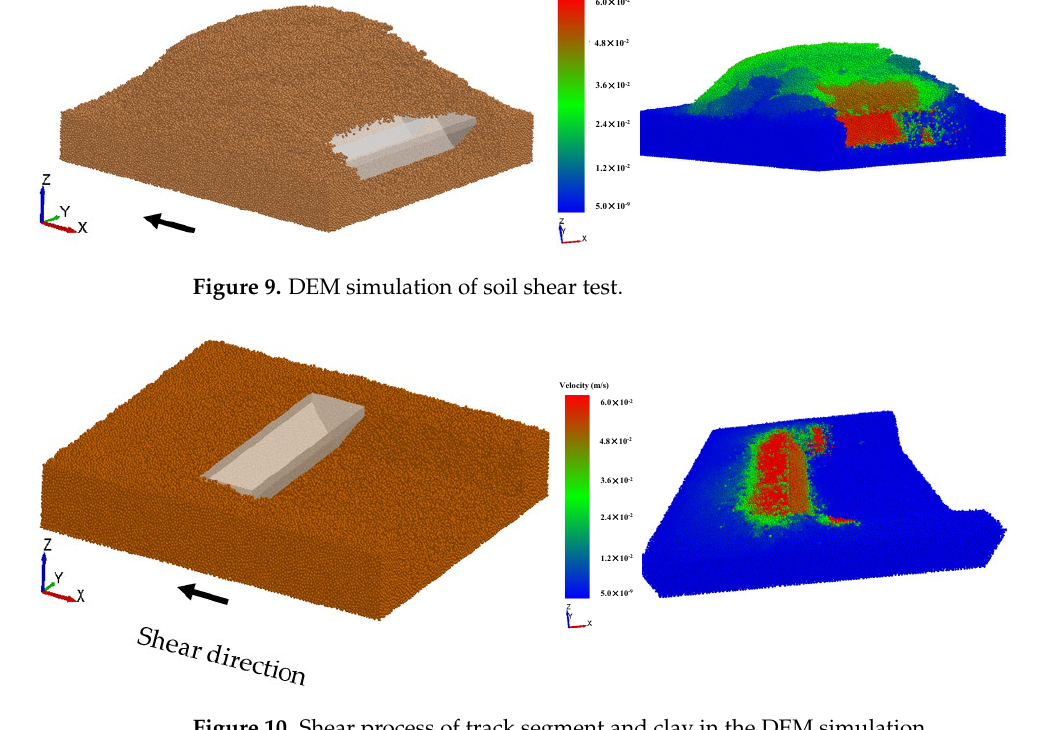
Figure 10. Shear process of track segment and clay in the DEM simulation.